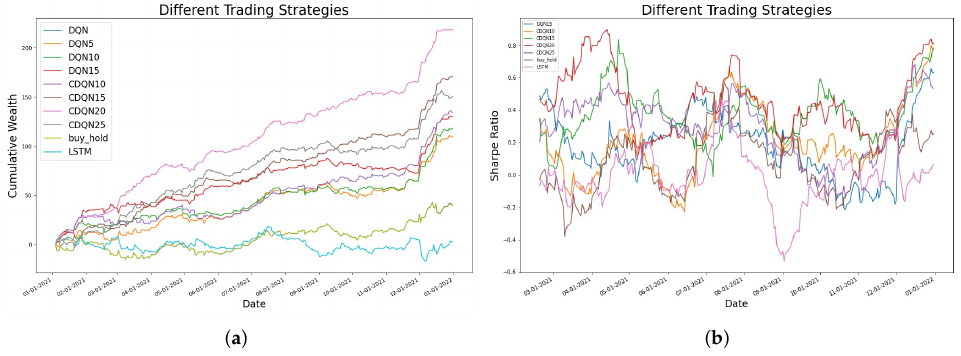
Figure 3. Different trading strategies for AAPL (Apple Inc.). ( a ) The left figure shows the cumulative wealth curves in 2021 using different trading algorithms including DQNn ( n ∈ { 1,5,10,15 } ), CDQNn ( n ∈ { 10,15,20,25 } ), Buy and Hold, and LSTM. ( b ) The right figure shows the Sharpe ratio curves in